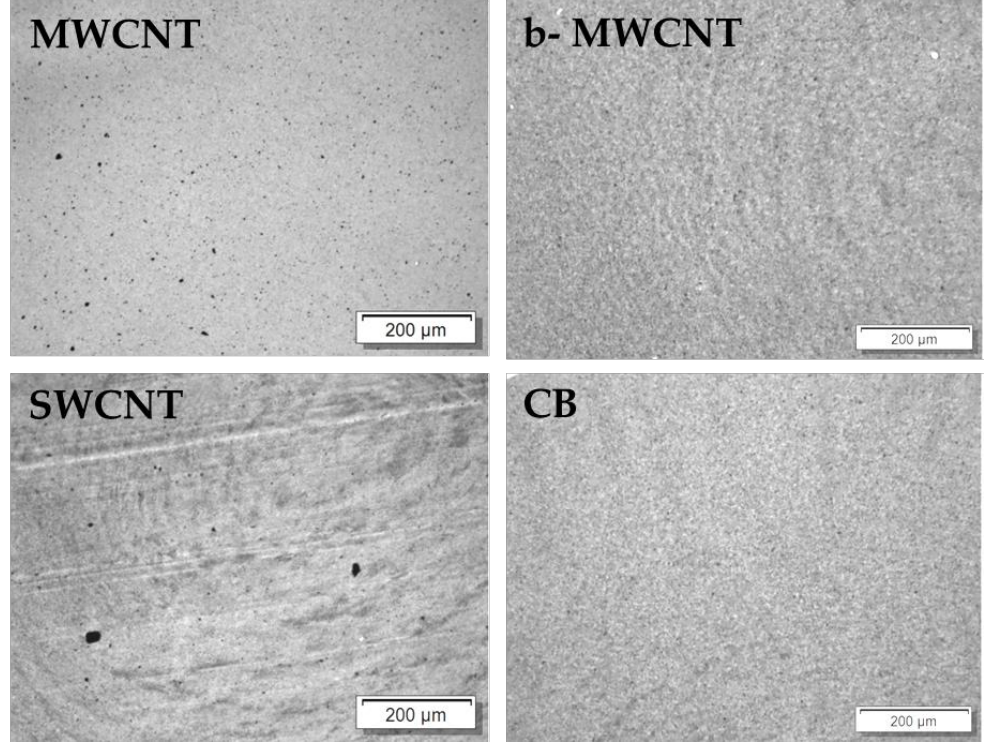
Figure 3. Transmission light microscopy (LM) images of poly (vinylidene fluoride) (PVDF) filled with 1.0 wt% of different kind of fillers.